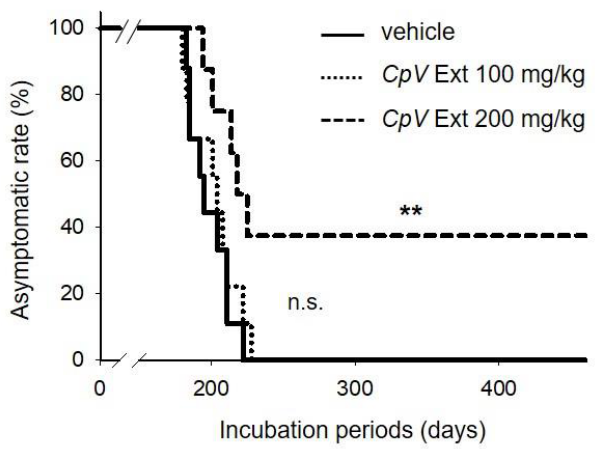
Figure 3. Suppression of prion disease in vivo by CpV extract. The disease onset curve of the prion- infected mouse groups (n = 9/group) that received 0, 100, or 200 mg/kg CpV extract twice a week for four weeks. **, p = 0.009 (vehicle group versus CpV Ext 200 mg/kg group); n.s., statistically not significant (vehicle group versus CpV Ext 100 mg/kg group).